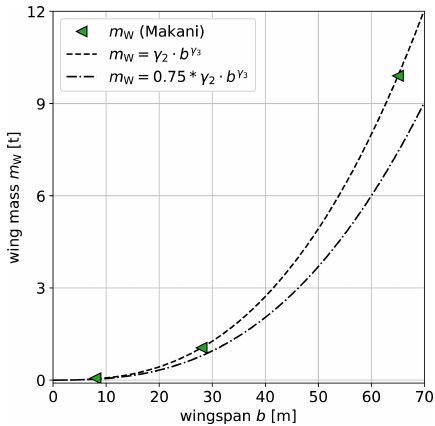
Figure 6. Scaling of the wing mass with the wingspan of the aircraft based on manufacturer data from Makani Power (Makani Power, 2012). The dashed line shows the power law fitted from data with γ 2 ≈ 0 . 1478 and γ 3 ≈ 2 . 662 used for drag-mode AWE systems while the dashed–dotted line shows the power law with a 25% reduction of the mass as used for lift-mode AWE